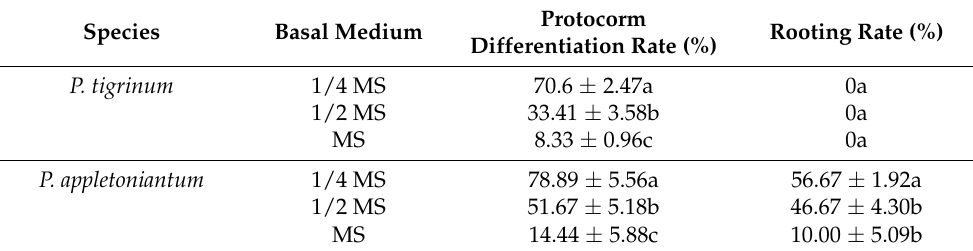
Table 4. Effect of basal medium on protocorm differentiation of Paphiopedilum tigrinum and P. appletoniantum .